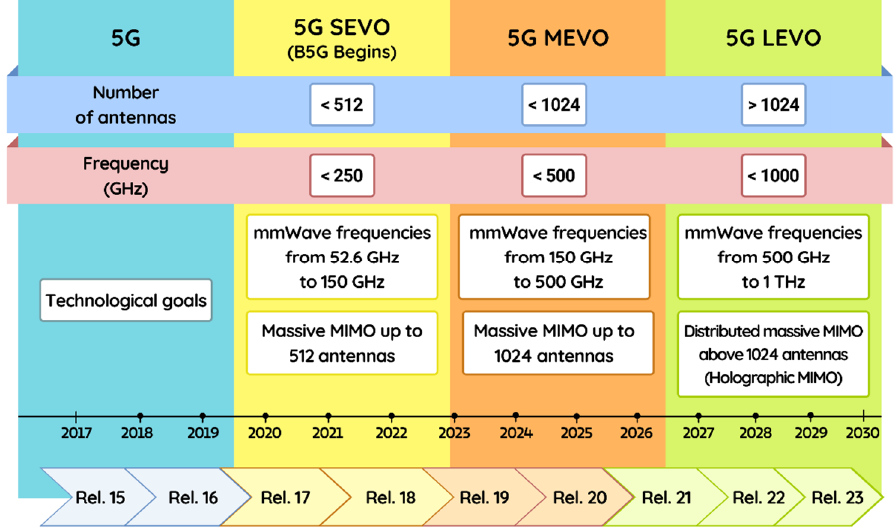
Figure 1. Evolution roadmap of the communication standards and major technological challenges for future mobile communications.